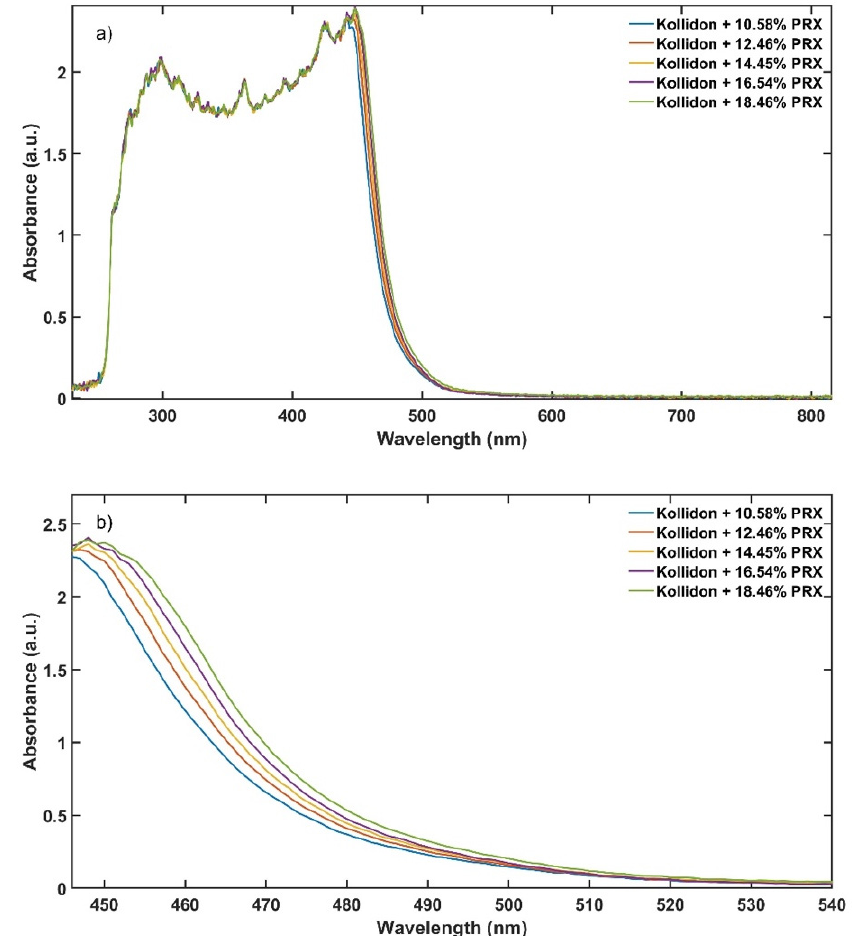
Figure 6. Absorbance spectra of the calibration data set, ( a ) full spectrum and ( b ) 446 to 540 nm range.